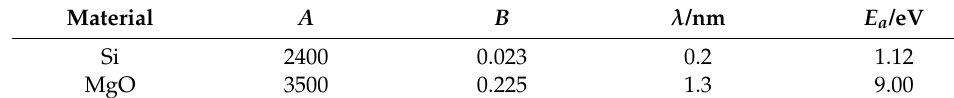
Figure 8. Fitted (lines) and measured (symbols) SEY curves of MgO/Si double-layer samples. Table 2. Fitting parameters of SEY curves for MgO/Si double-layer samples.